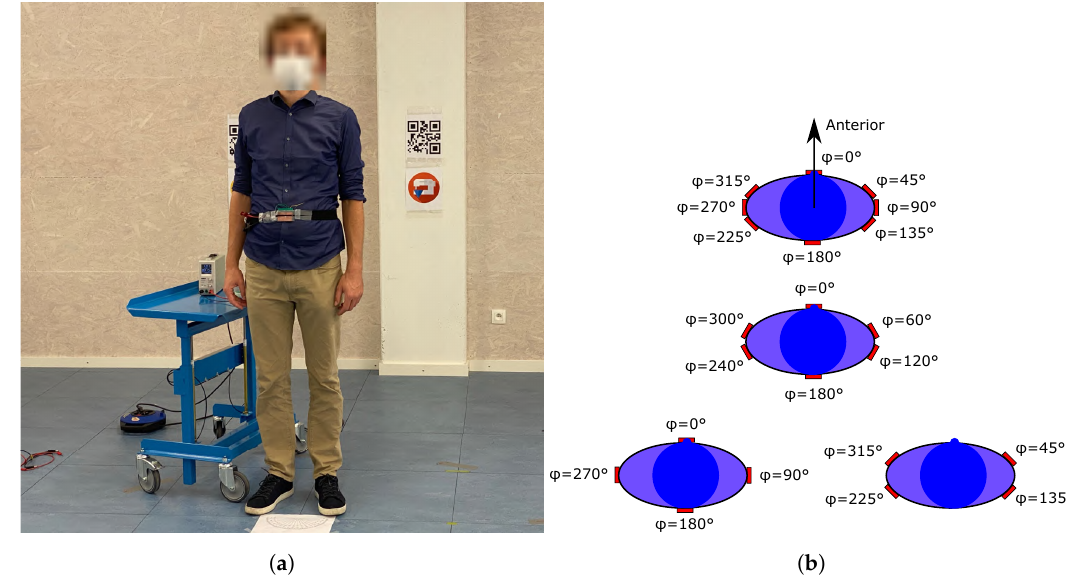
Figure 10. Deployment on the user’s body. ( a ) Test subject fitted with the belt hosting the sensor node. This is the on-body deployment position for φ = 0 ◦ . The system is powered by an external power source for measurement purposes. ( b ) Some scenarios for 8 (top), 6 (middle), and 4 (bottom) body-deployment positions. Two possible configurations for 4 body-deployment positions are